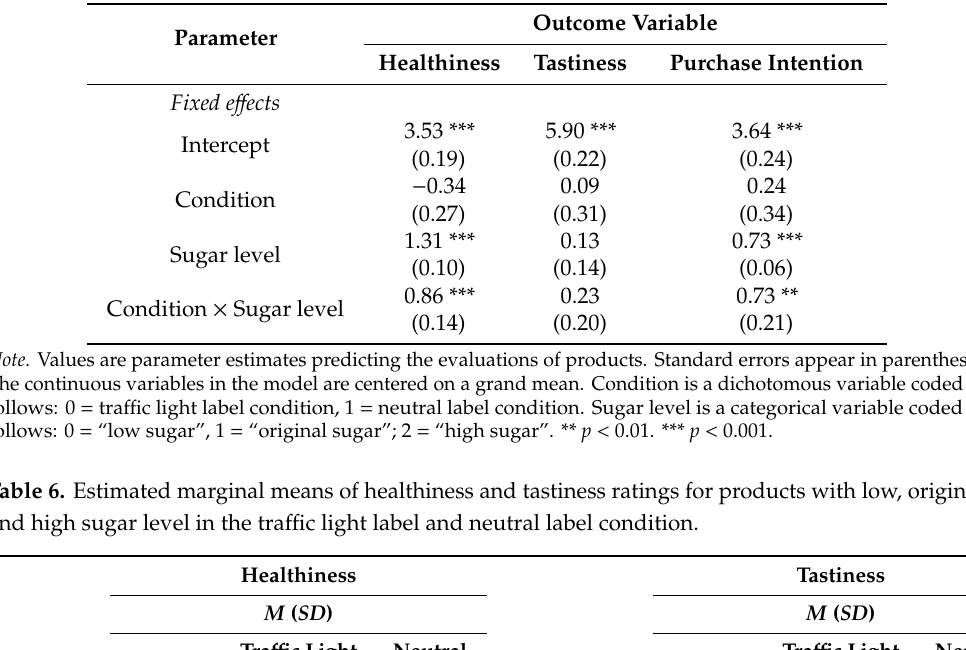
Table 5. Parameter estimates of the e ff ects of sugar level and condition on healthiness evaluations, tastiness evaluations, and purchase intentions, using linear mixed-e ff ect model analysis.